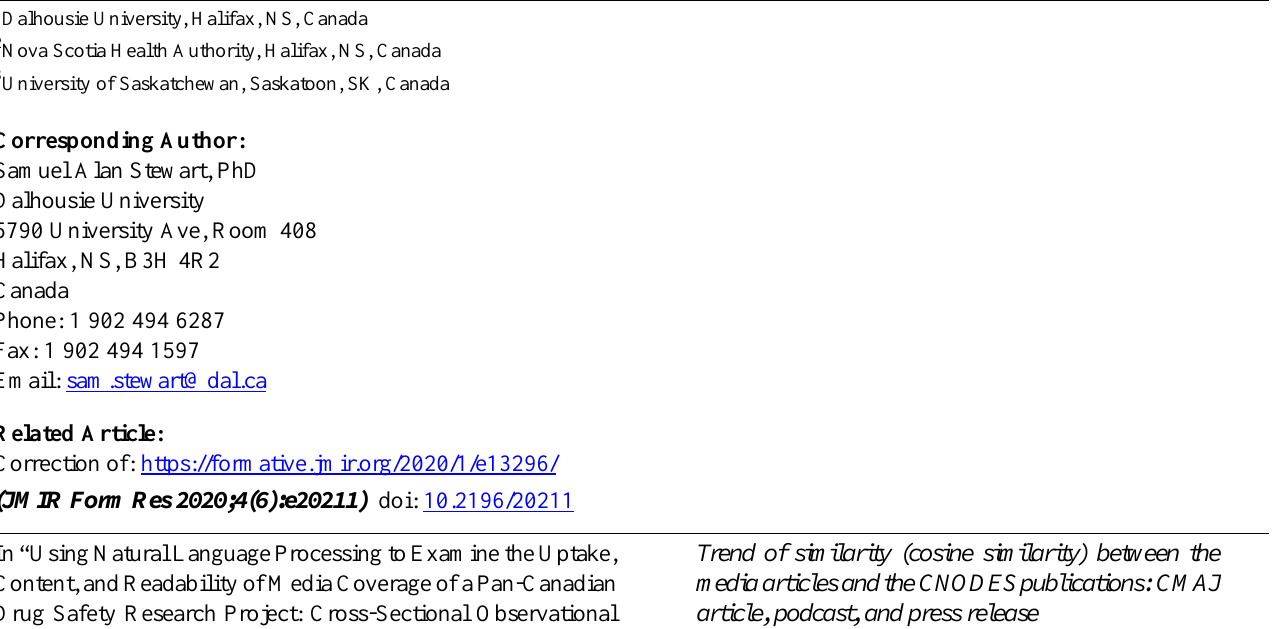
Figure 4's legend has been revised from: Similarity of all articles to three original articles (press release, podcast, and CMAJ article) to: Distribution of readability levels of articles based on text-standard